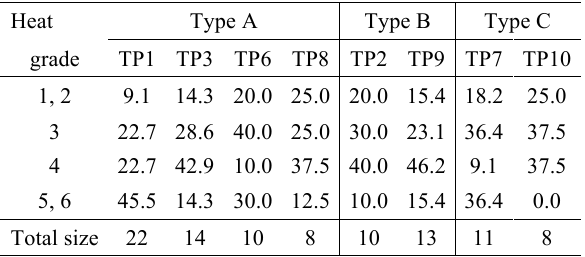
Proportion of the community members by heat grade ( % ).